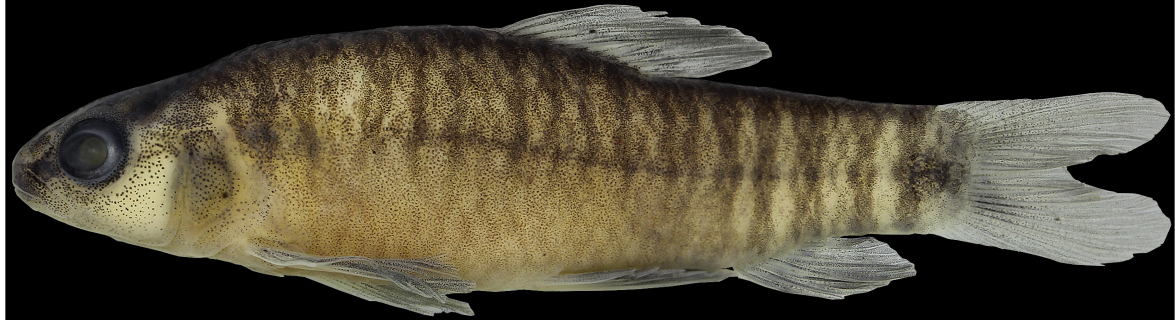
Figure 1. Characidium xavante , CPUFMT 6368, 31.0 mm SL, unnamed stream from the Kaaiapó River drainage, tributary of the Teles Pires River, upper Tapajós River basin, Paranatinga municipality, Mato Grosso State, Brazil.